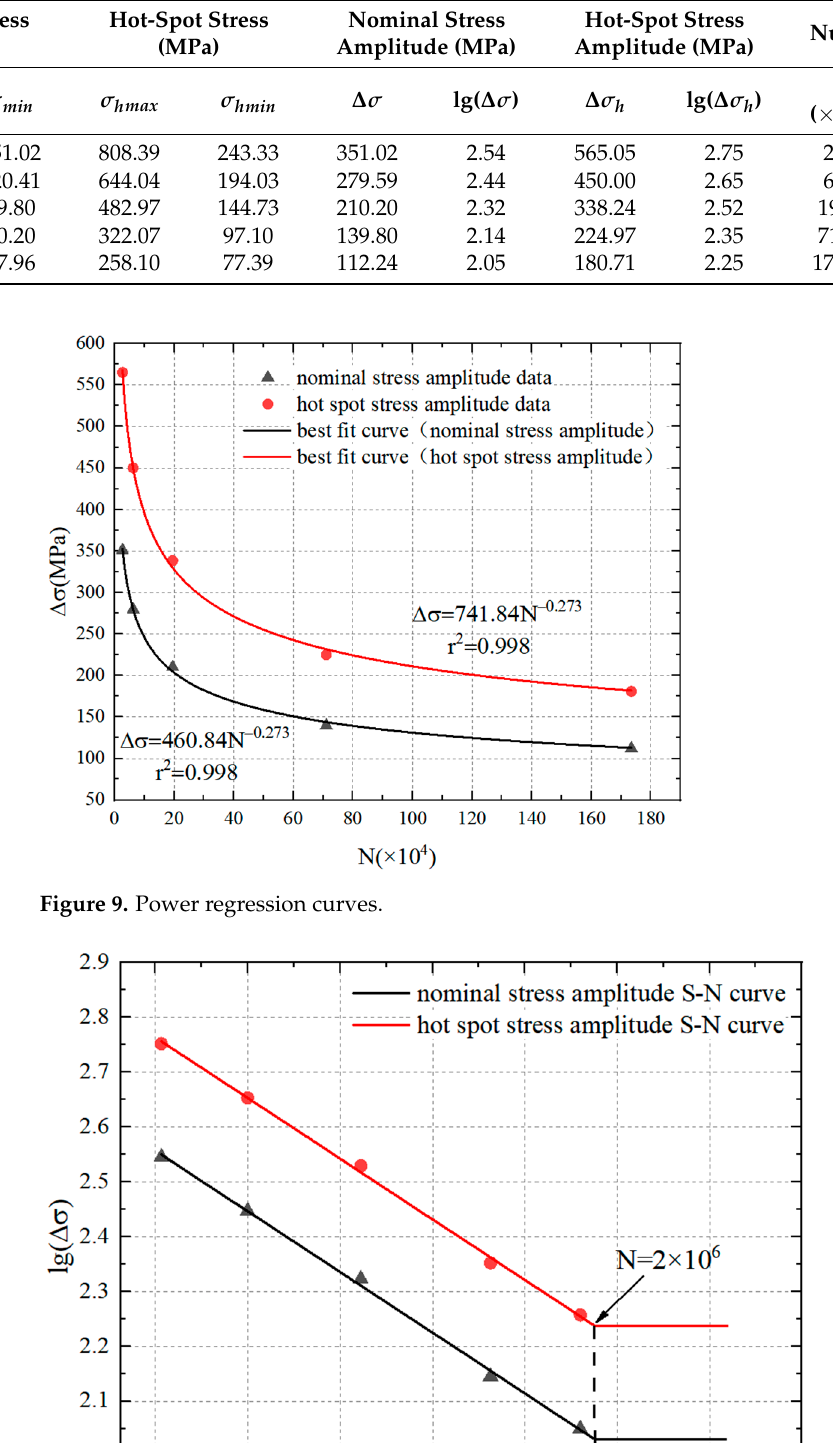
Table 3. Hot-spot stress and hot-spot stress amplitude of M20 torque-shear HSBs without pretension.